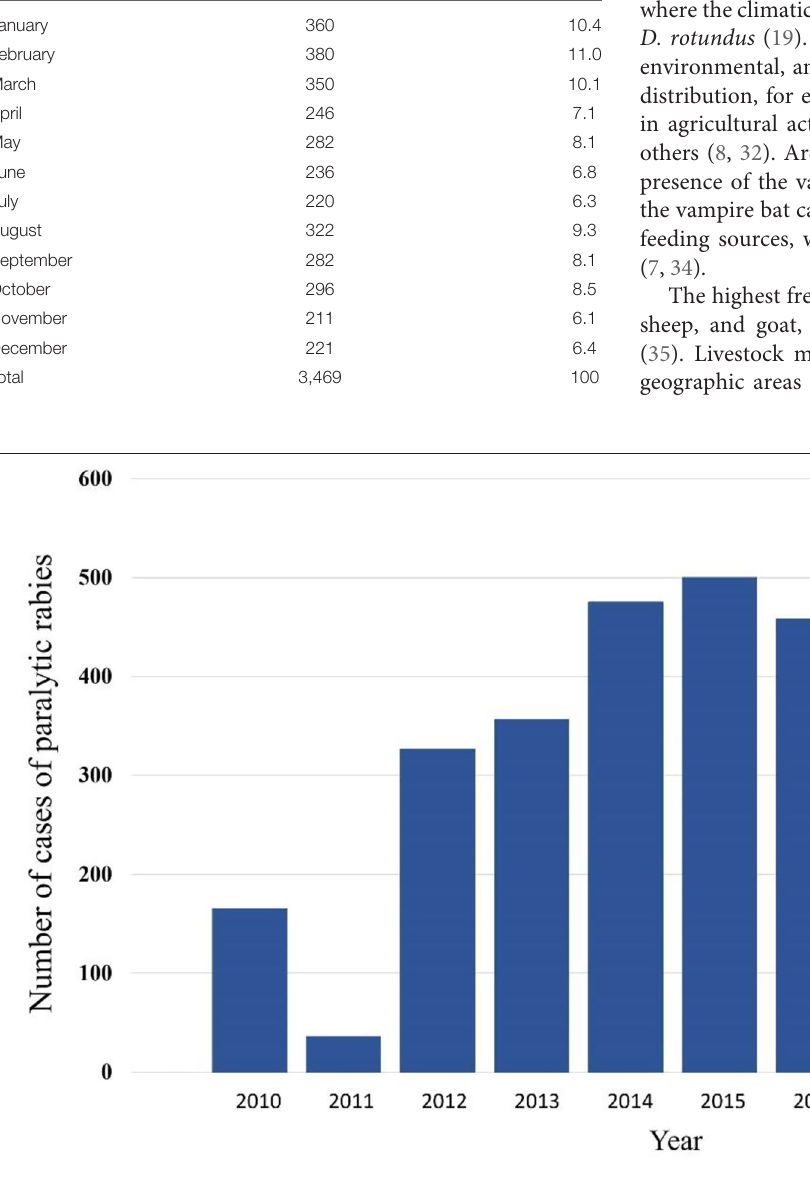
Frontiers in Veterinary Science |